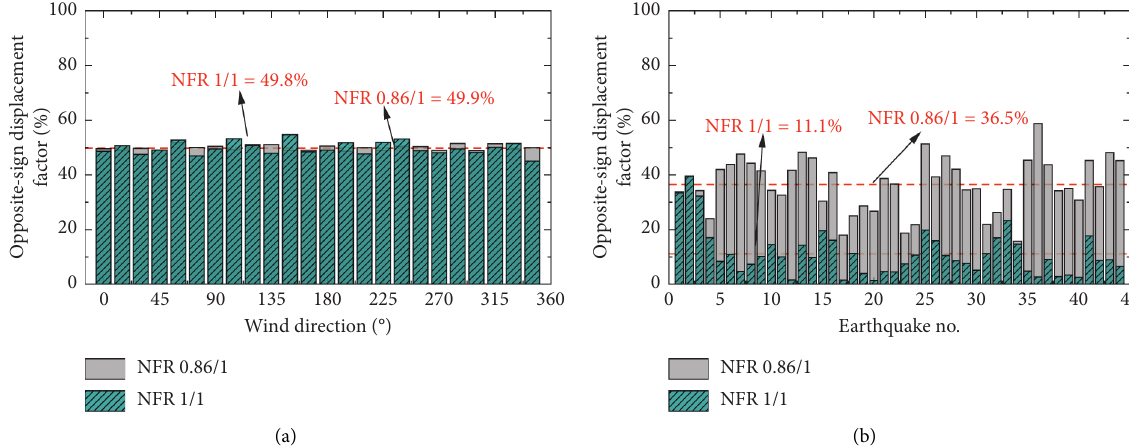
Figure 7: Variation of opposite-sign displacement factor at 210.2 m height under (a) 24 wind directions and (b) 44 earthquake excitations.